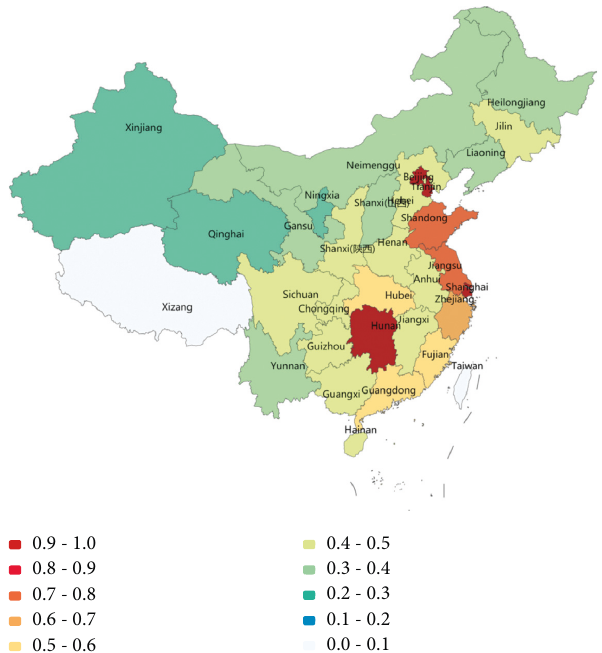
Figure 9: 2020 EEE value in China.